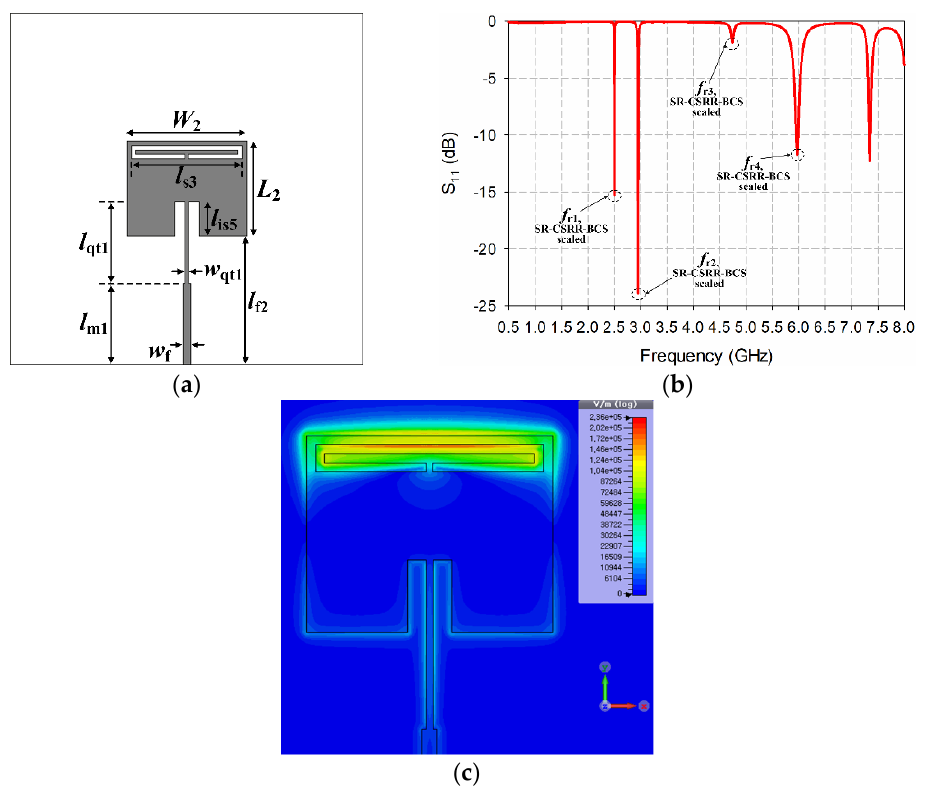
Figure 10. Scaled radiating edge ‐ aligned SR ‐ CSRR ‐ BCS slot ‐ loaded MPA with the first resonant frequency at 2.5 GHz: ( a ) antenna geometry, ( b ) input reflection coefficient characteristic, and ( c ) electric field distribution at 2.5 GHz.